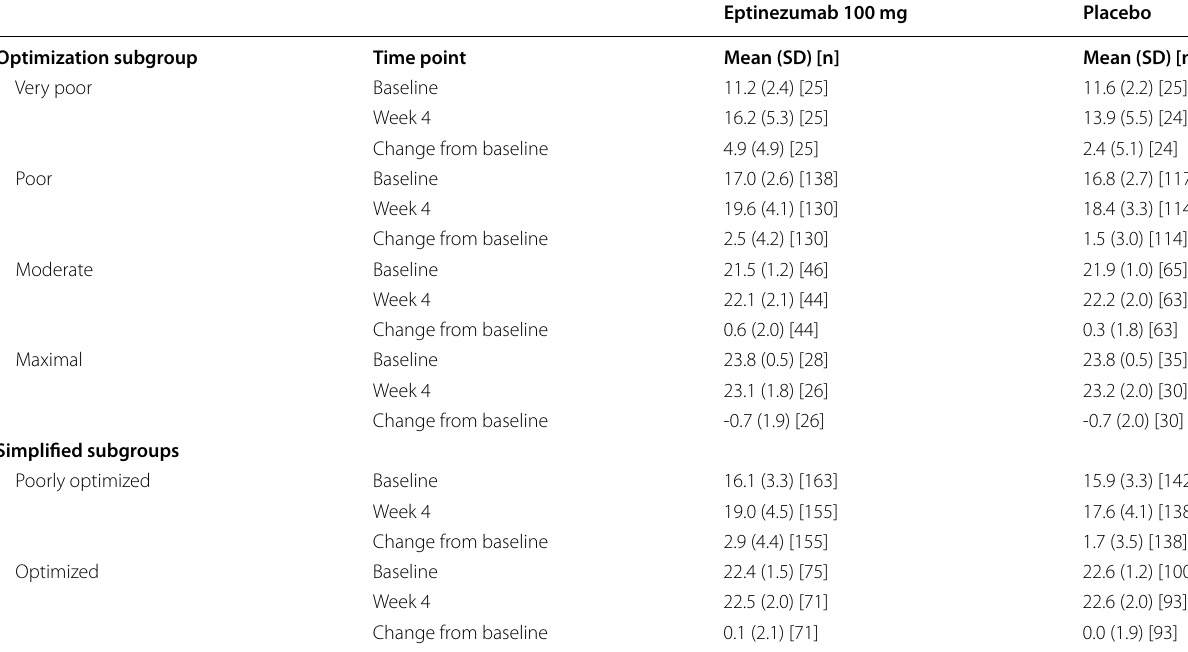
Patients were grouped by baseline mTOQ-4 total scores into the following optimization categories: very poor (0), poor (1–5), moderate (6–7), and maximal (8). Simplified subgroups consist of patients with mTOQ-4 total scores in very poor (0) and poor (1–5) categories together, along with patients with total scores in the moderate (6–7) and maximal (8) categories grouped together. Epti, eptinezumab (100 mg); mTOQ-4/mTOQ-6, 4-item/6-item Migraine Treatment Optimization